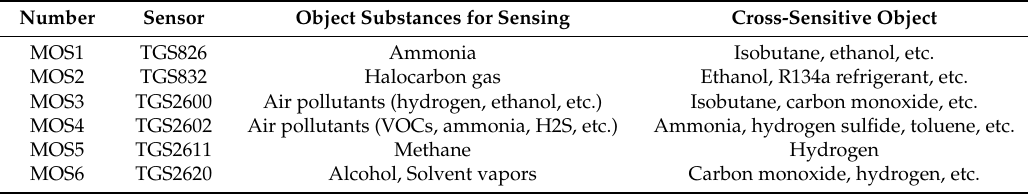
Table 1. Standard sensor array in E-nose